Question: Which visualization type does this figure use?
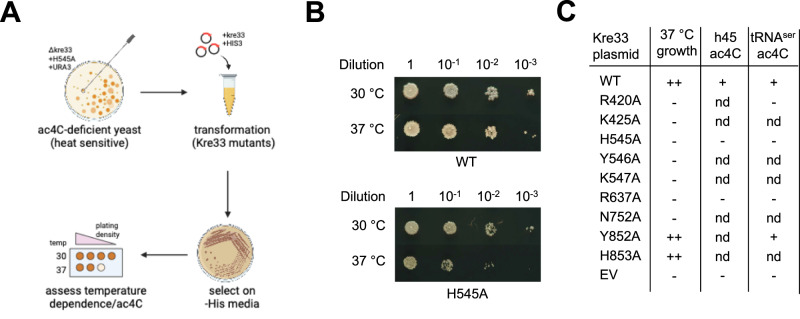
Answer: line